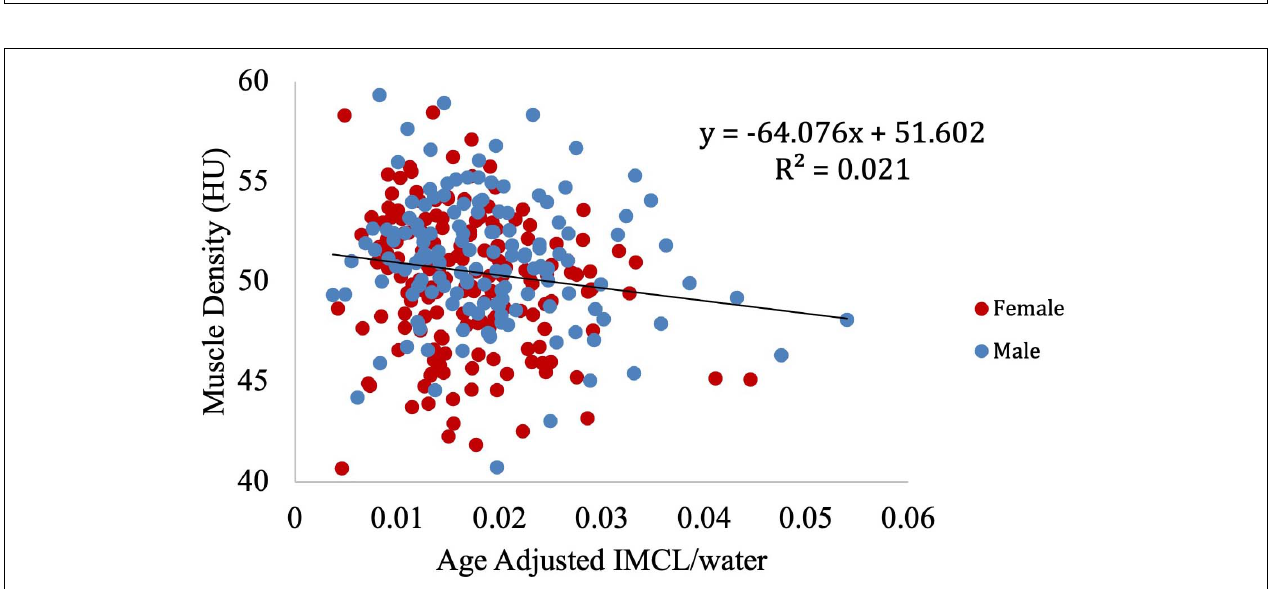
FIGURE 10 | Relationship between muscle density from CT and waist circumference ( p < 0.01). This relationship remained significant ( p < 0.01) after adjustment for IMCL/water.